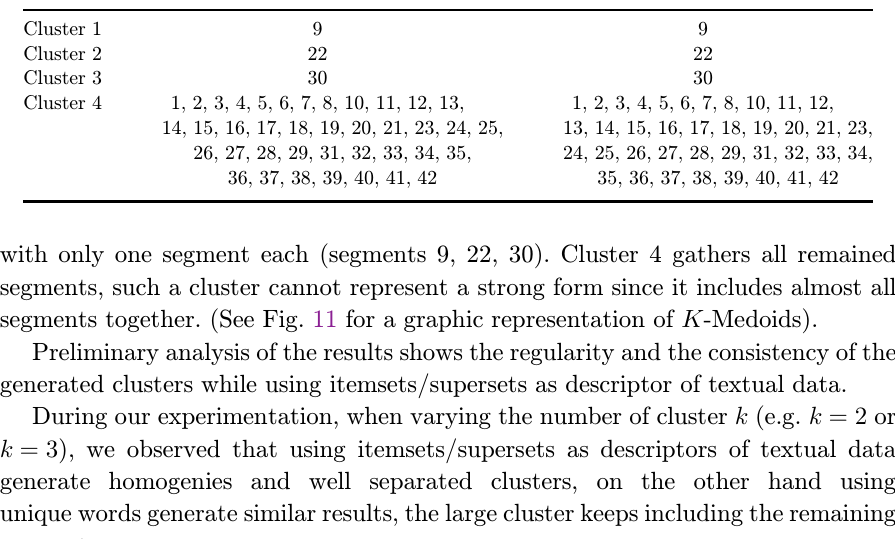
Table 6. Comparative table for words as descriptor of textual data. HClust